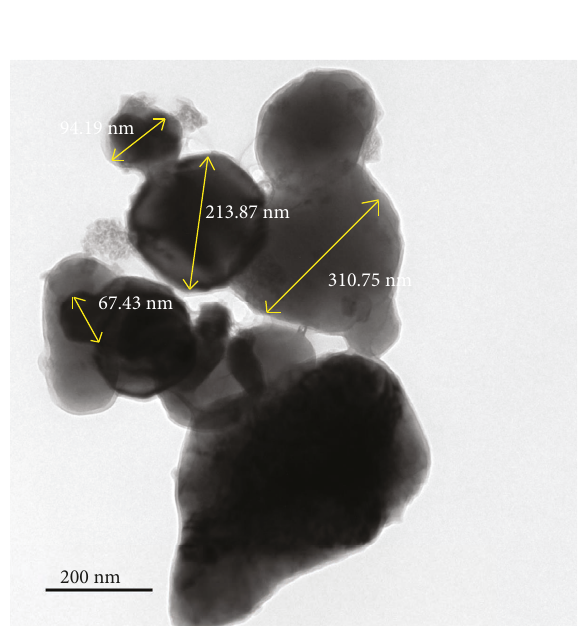
Figure 5: TEM image of synthesized FeS